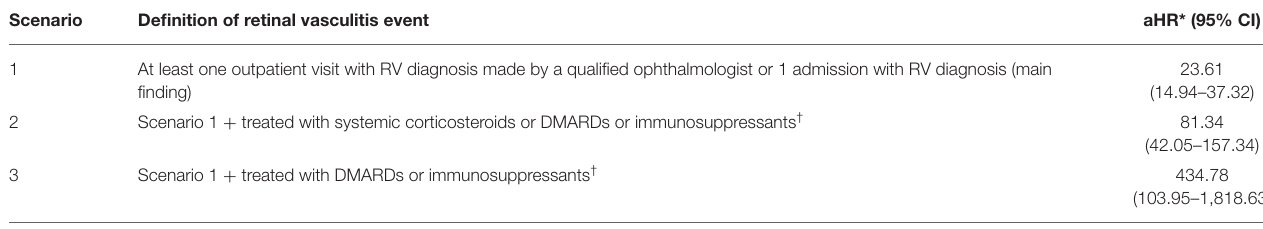
TABLE 4 | Sensitivity analysis in the estimation of the retinal vasculitis risk for SLE exposure in age-matched and sex-matched populations.